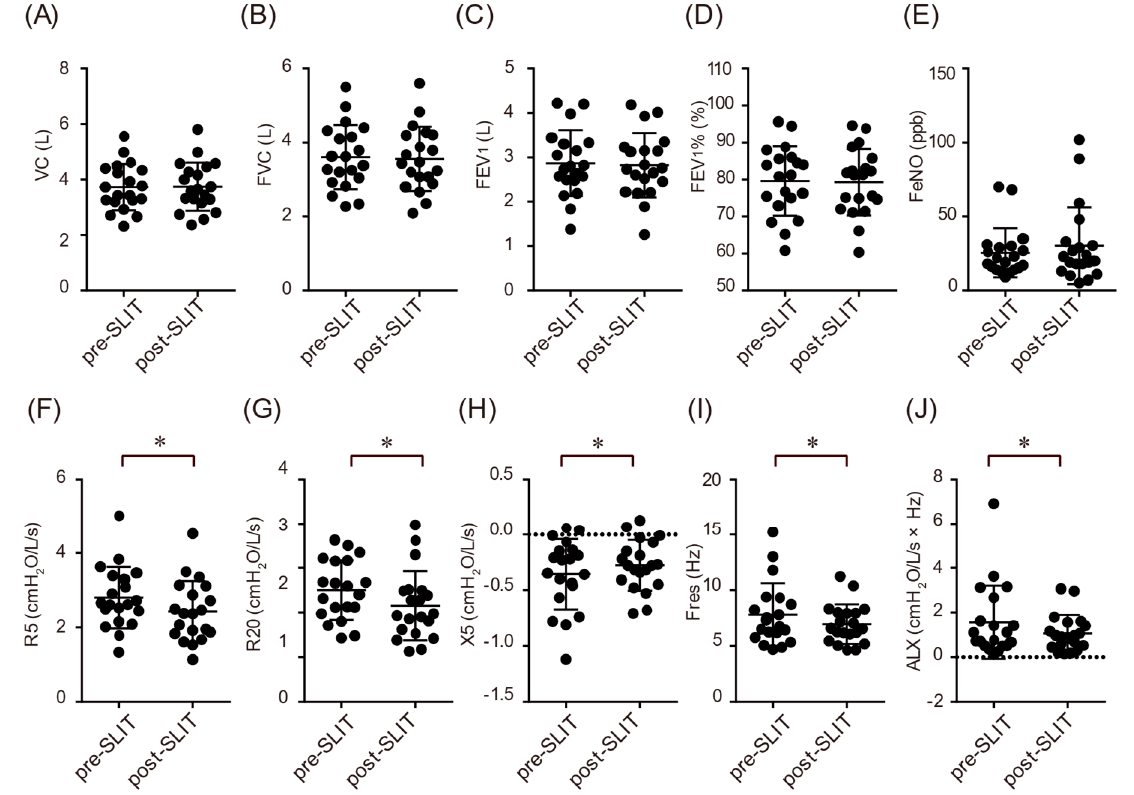
Figure 2. Changes in respiratory function (VC ( A ), FVC ( B ), FEV 1 ( C ), FEV 1 % ( D )), FeNO levels ( E ), and forced oscillation technique (FOT) parameters (R5 ( F ), R20 ( G ), X5 ( H ), Fres ( I ), ALX ( J )) before and after SLIT during the off-season. The values of FOT parameters are presented in whole breath. Bars indicate median values. Abbreviations: ALX, a low-frequency reactance area; FeNO, a fraction of exhaled nitric oxide; FEV 1 , forced expiratory volume in one second; Fres, resonant frequency; FVC, forced vital capacity; R5 and R20, resistance at 5 Hz and 20 Hz; X5, reactance at 5 Hz; VC, vital capacity. The measurements were averaged over several tidal breaths (whole-breath analysis). Each bar represents the mean ± SD. * p <